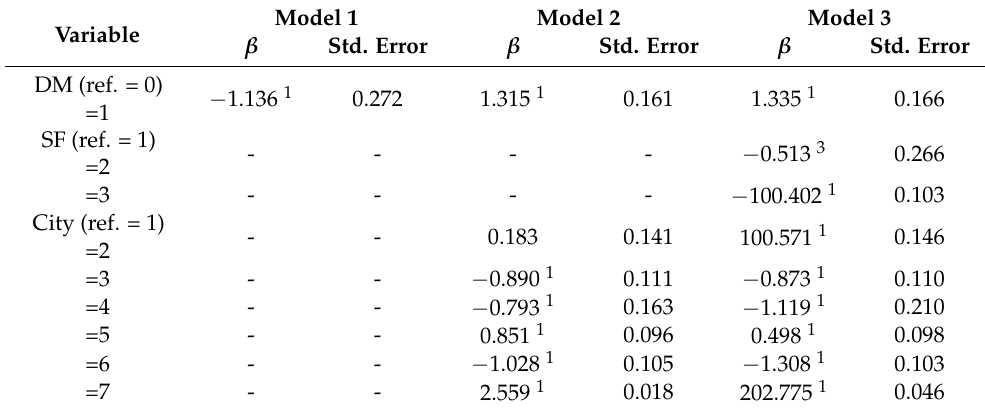
Table 5. Results of multinomial ordered logit estimates for testing Hypothesis